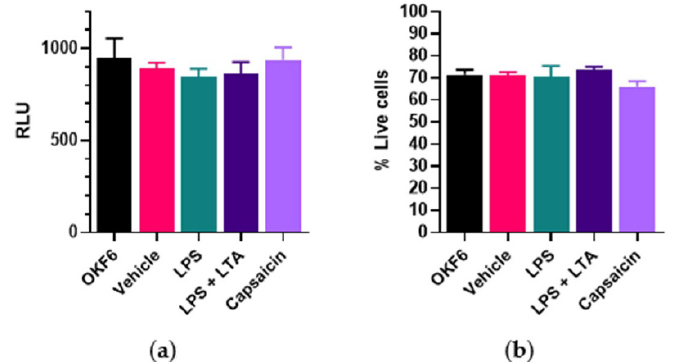
Figure 3. Bacterial antigens and capsaicin treatment on normal oral cell OKF6 metabolism and viability. OKF6 cells were plated at 5000 cells/well and incubated with drug vehicle (0.1% DMSO), LPS (5 µg/mL), combined LPS (5 µg/mL) + LTA (5 µg/mL) and capsaicin (150 µM) for 24 h. ( a ) Cell metabolism was determined by the MT Glo assay. RLU = relative luminescence unit. ( b ) Cell viability was determined by the Trypan blue exclusion assay. n = 6 biological replicates. Error bars represent standard error of the mean.